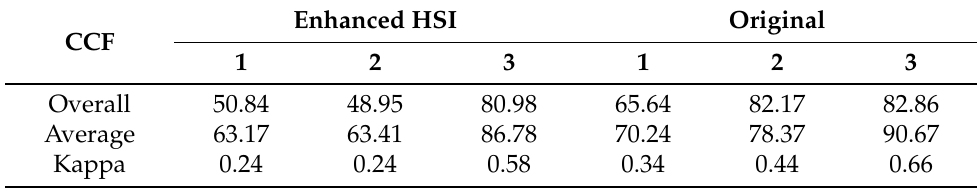
Table 1. Classification accuracies for the canonical correlation forest (CCF) algorithm